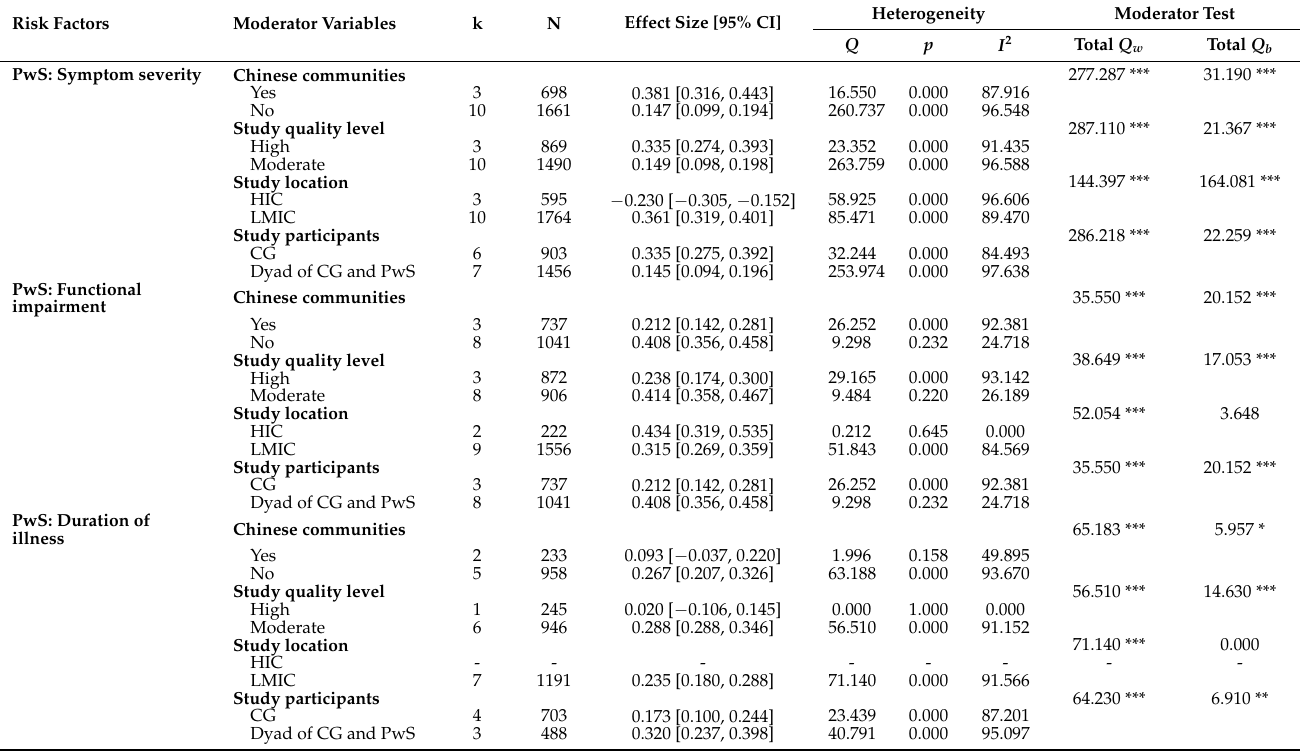
Table 3. Moderating variables of the correlations between clinical risk factors and caregiver